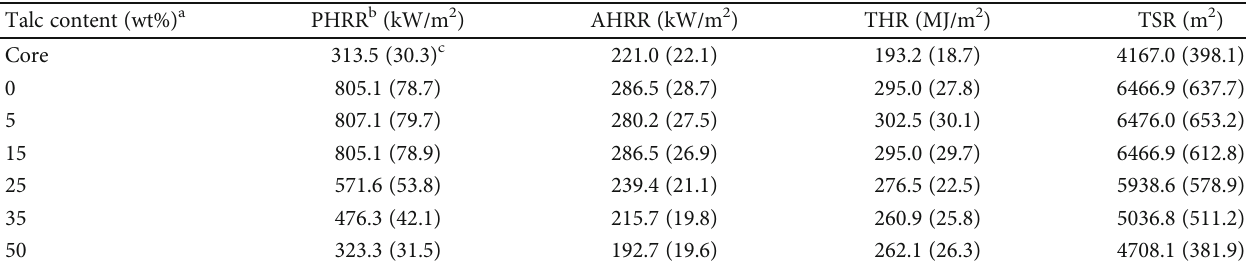
Table 3: Summary of fl ammability